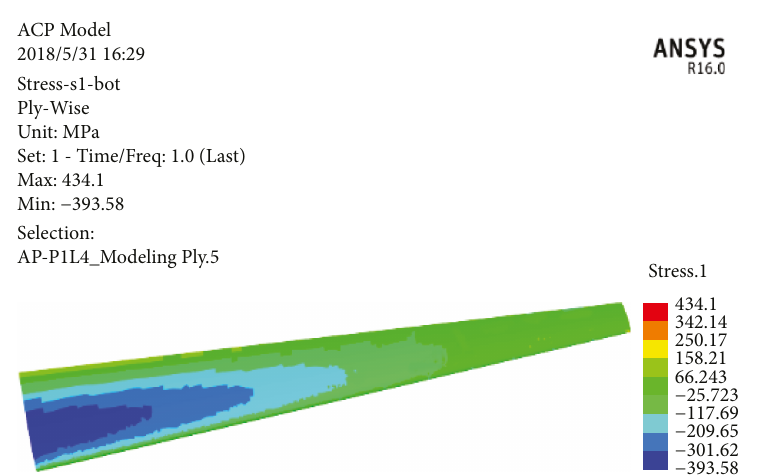
Figure 42: Stress cloud diagram of the upper wing with the layer ratio being 10%/10%/80%.